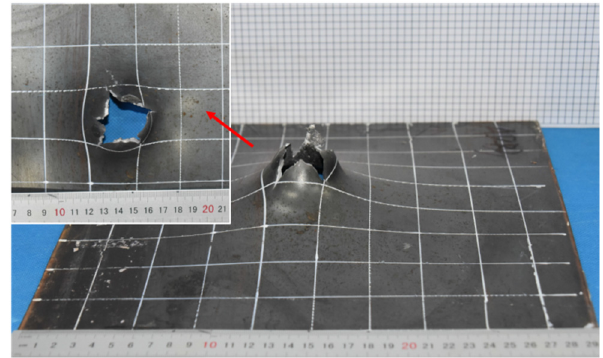
Figure 12. Dishing deformation-petaling failure.